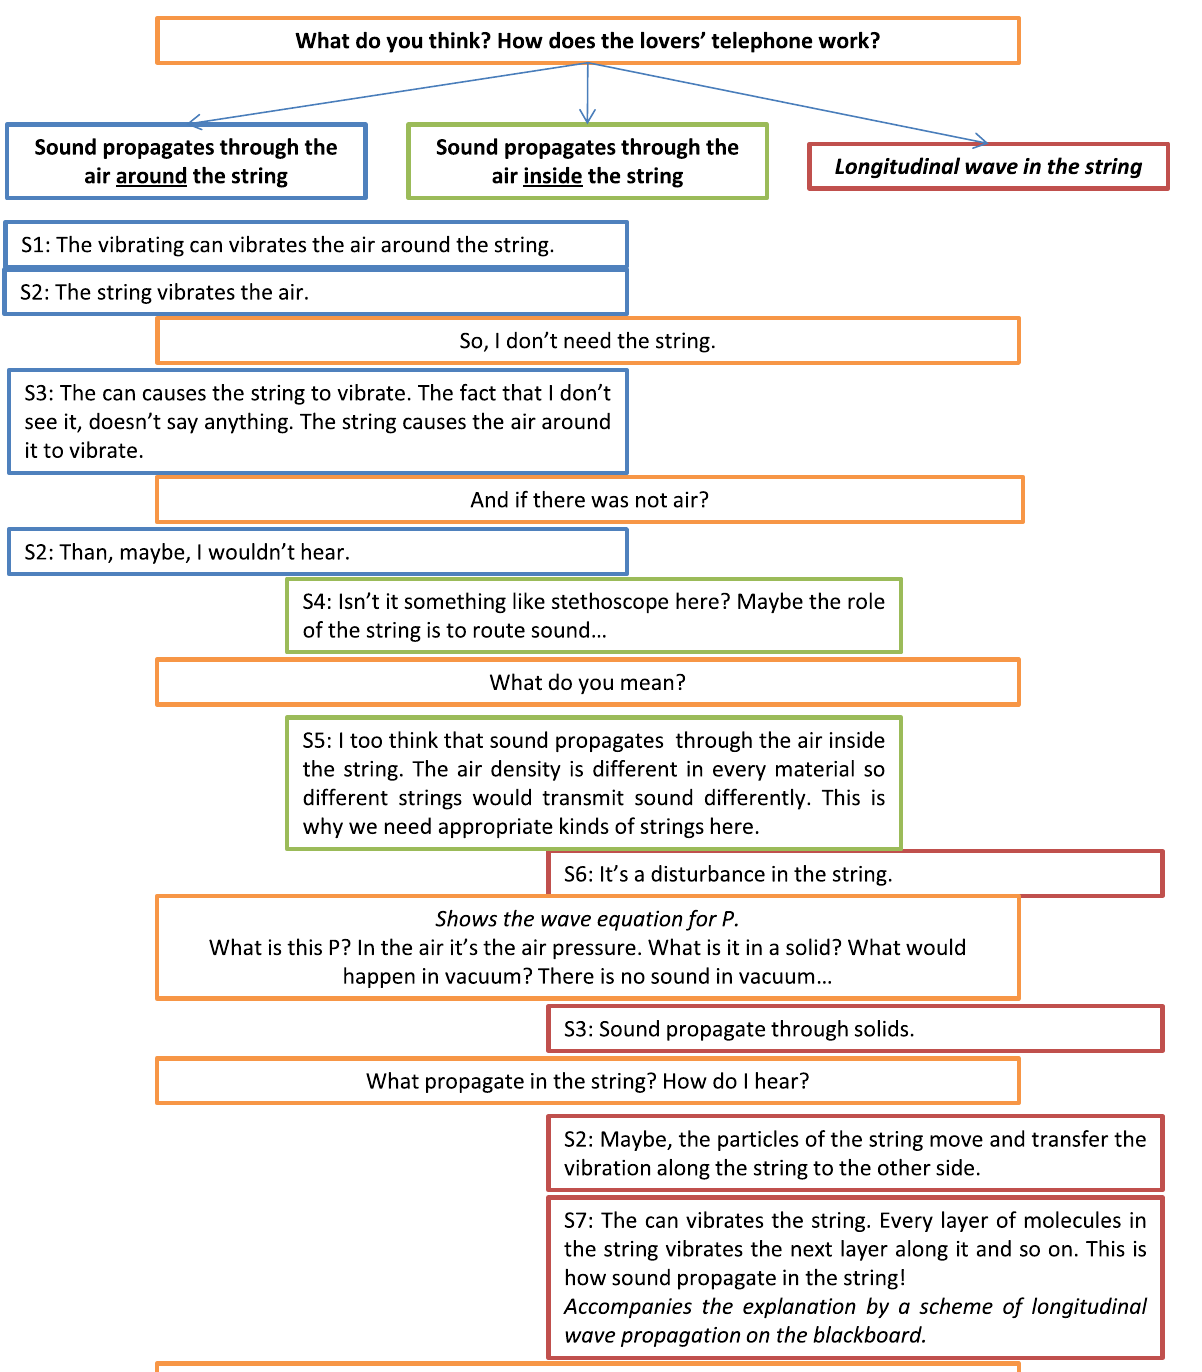
FIG. 6. WCDD about the physical principles of a lovers ’ telephone. The lecturer ’ s interventions are shown in the orange boxes; sound propagates through the air around the string ideas are shown in the blue boxes; inside the string are shown in the green boxes; longitudinal wave in the string are shown in the red boxes. The CFDM is characterized by the accumulation around three budding foci concepts